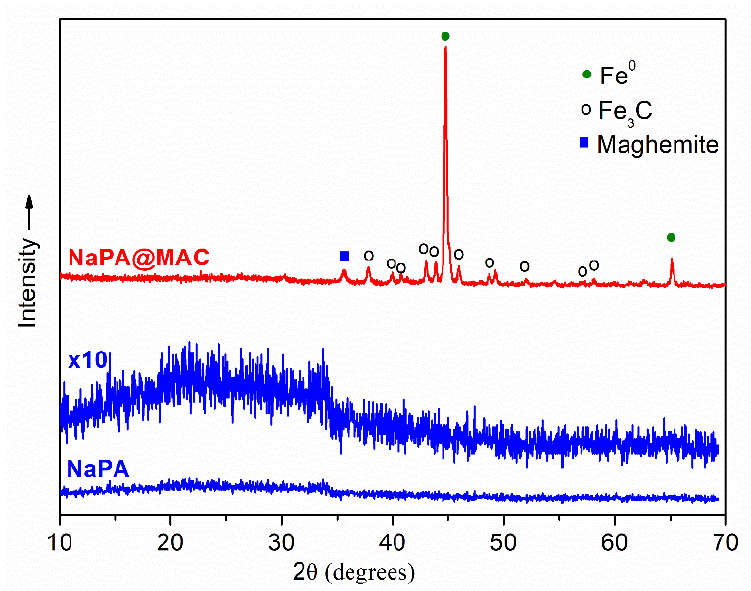
Figure 2. X-ray diffraction patterns of NaPA and NaPA@MAC Figure 2 . X-ray diffraction patterns of NaPA and NaPA@MAC samples.